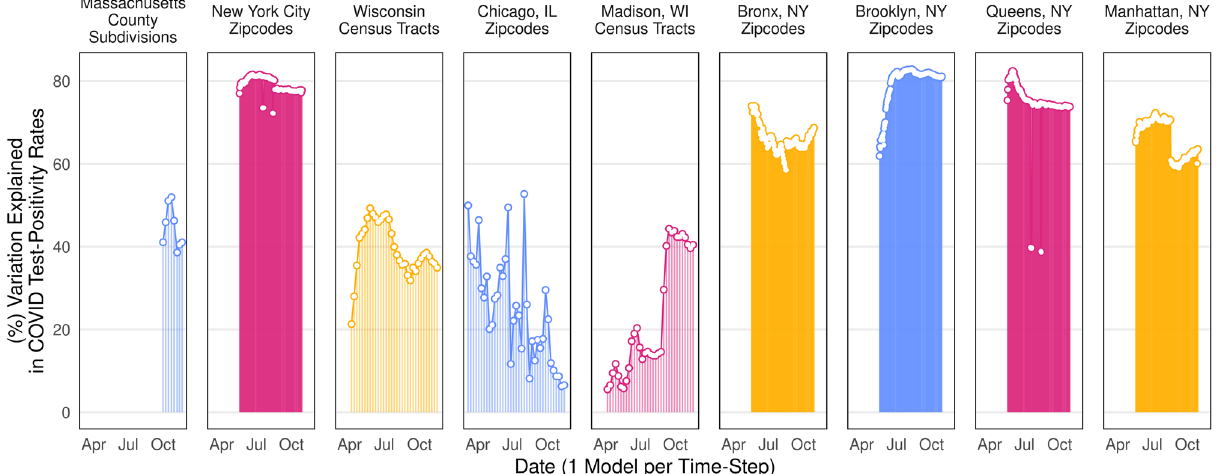
Figure 3. Variation explained by model covariates over time. Points depict variation explained (R 2 statistic) from dozens of fully specified OLS models for each time-step. Indicates substantial variation explained by model covariates, separate from time.